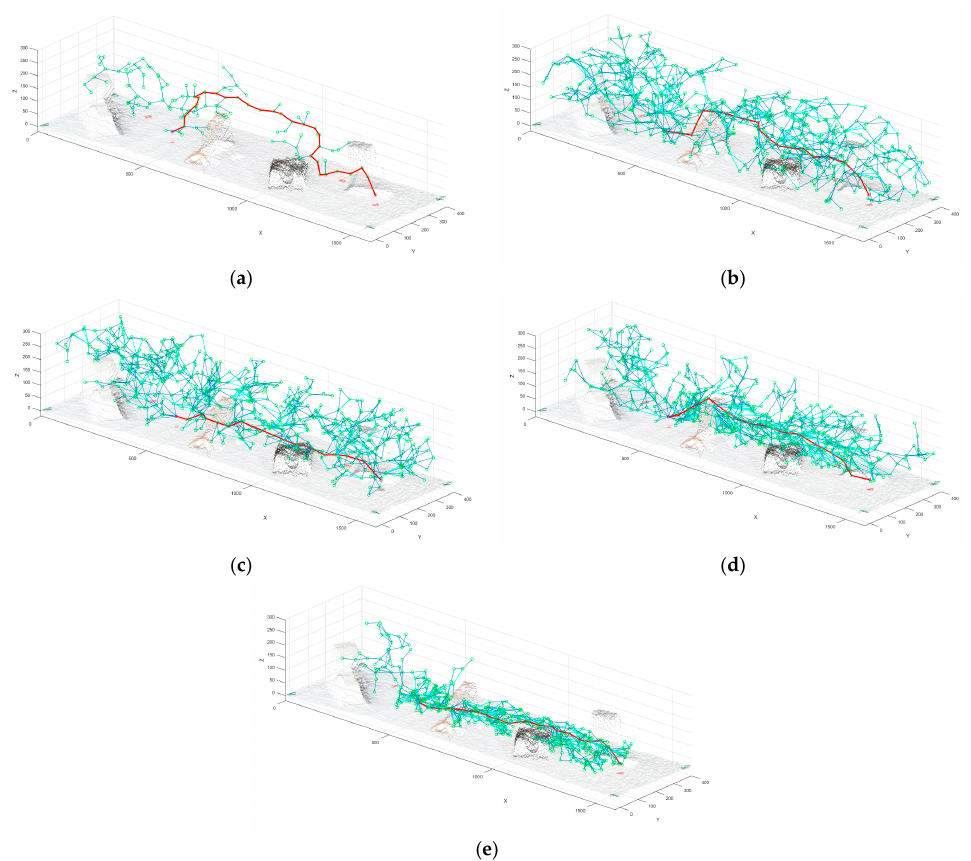
Figure 14. Comparison between RRT* algorithms in a simulation example (600 iterations) in a workspace with three obstacles between the start and goal point. The edges of the tree are presented in blue. The best path that reaches the goal is highlighted in red. ( a ) The RRT standard; ( b ) the RRT*; ( c ) the RRT* Goal; ( d ) the RRT* Limits and ( e ) the RRT* GL.